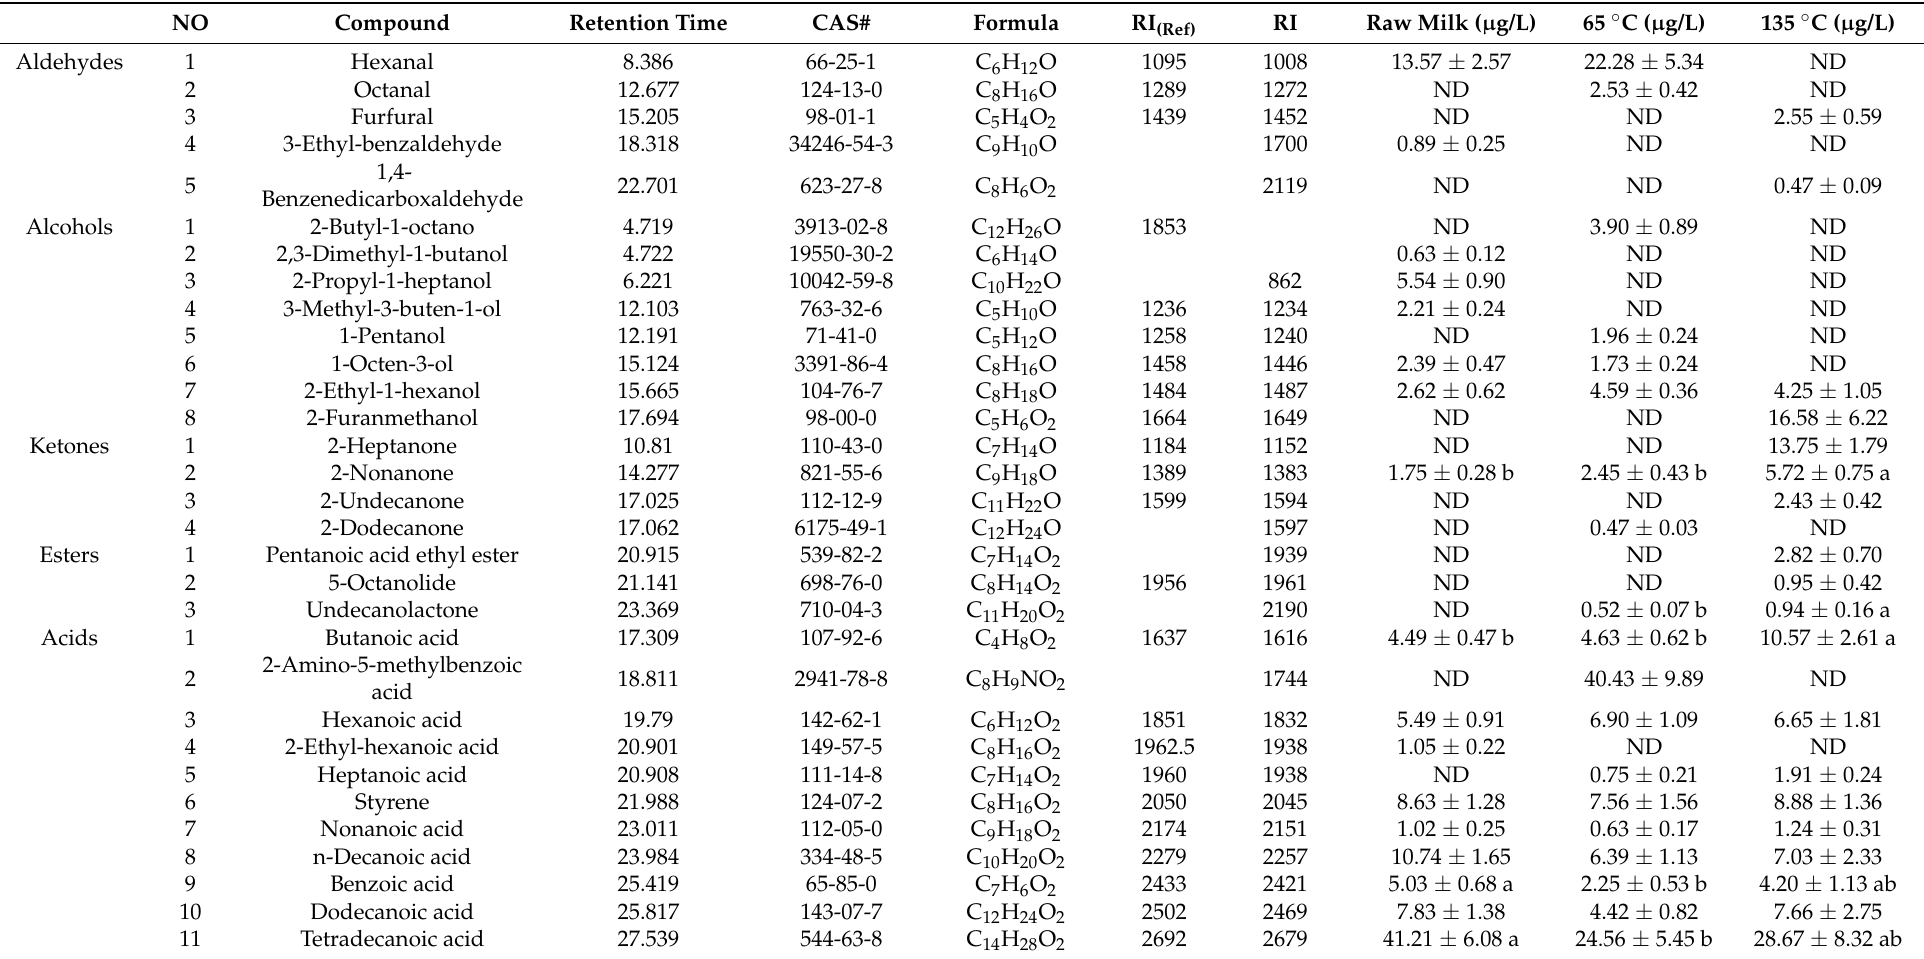
Table 4. The types and contents of VOCs in milk under different processing